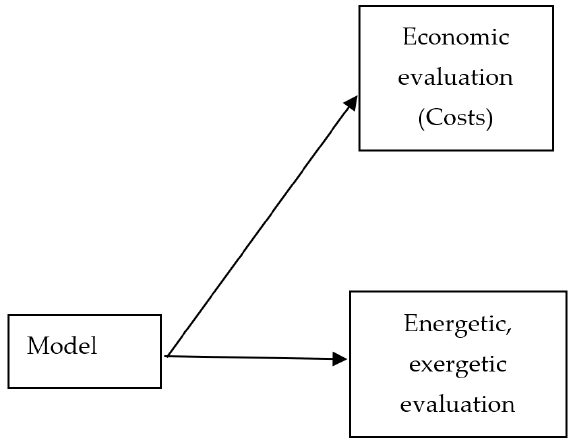
Figure 3. Energy, exergy and economic block diagram.